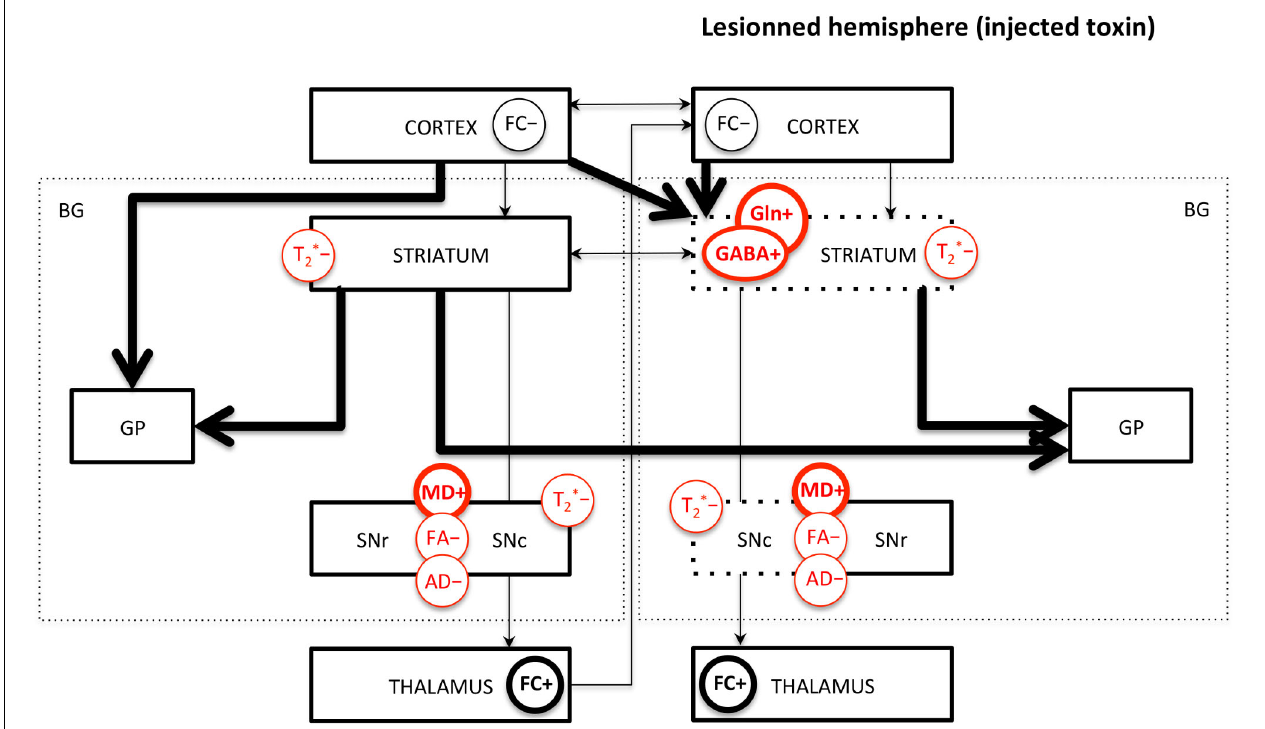
FIGURE 4 | Main MRI/MRS findings in PD rodents affecting the basal ganglia pathways. FC, functional connectivity; MD, mean diffusivity; FA, fractional anisotropy; AD, axial diffusivity; GABA, γ -aminobutyric acid; Gln, glutamine; T 2 *, effective transverse relaxation time. “+” means increase and “-” means decrease of the MR measure. Measures indicated in red are commonly found across studies. Thick/thin lines represent increased/decreased measure. Arrows represent FC changes between structures. For toxic models, the dotted lines represent the lesioned structures; the left/right side of the figure represents the intact/lesioned